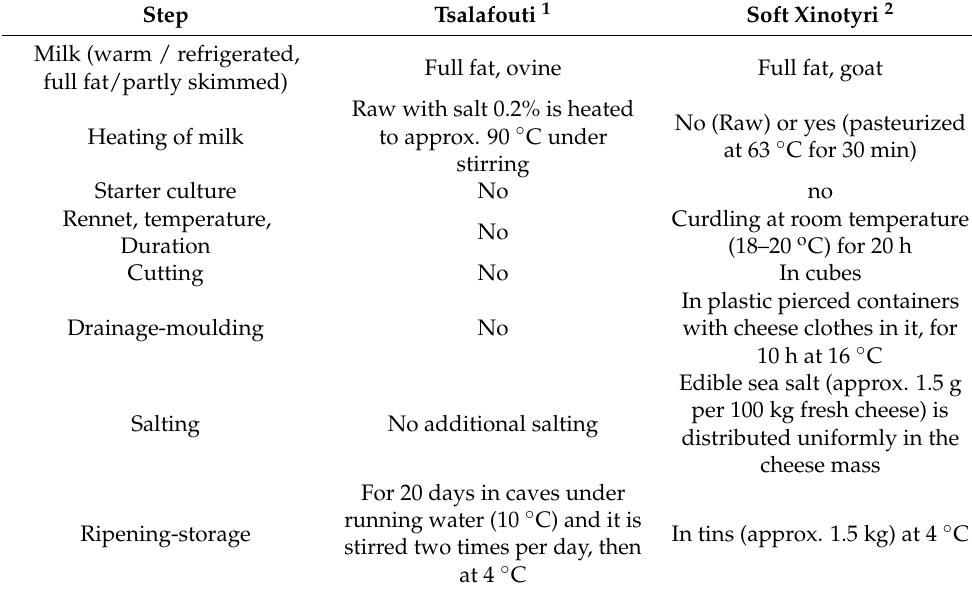
Table 9. Manufacturing technology of nonprotected designation of origin and nonprotected geo- graphical indication spread